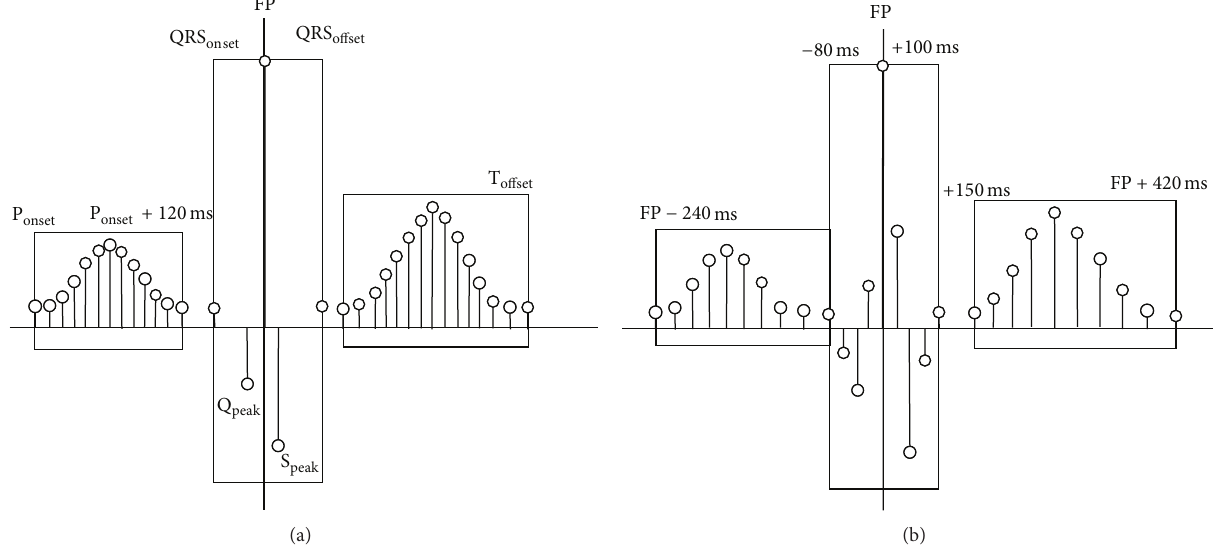
Figure 3: Extraction of ECG morphological features from heartbeat where fiducial point (FP) represents the position of R peak . (a) normal signal and (b) scaled